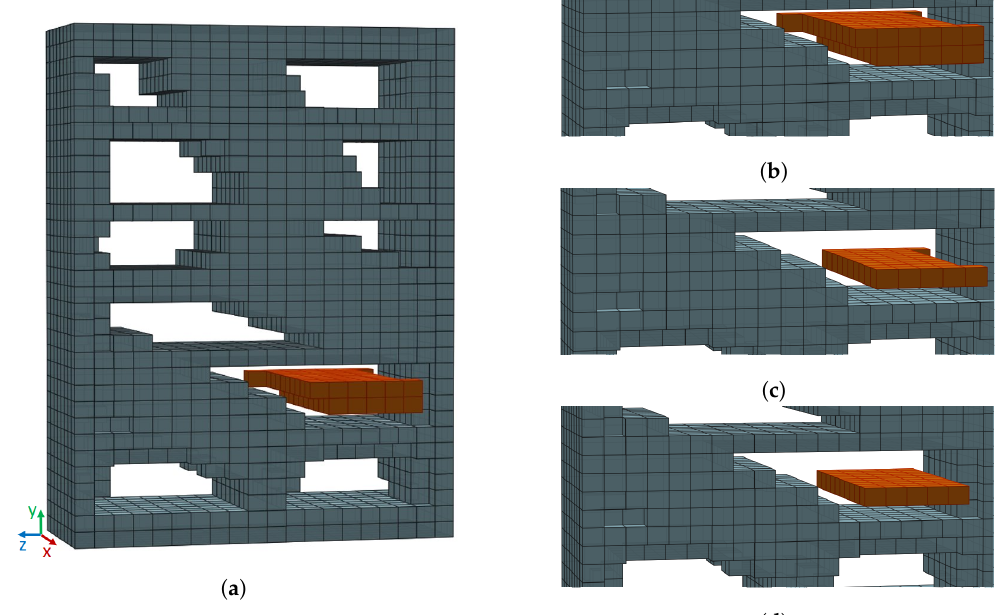
Figure 2. Example of voxelized storage furniture model (bookshelf) with detected free space core (FSC—orange voxels). ( a ) Front view of furniture model with selected FSC ( b ) FSC zoomed, ( c ) One FSC layer in y -axis direction, ( d ) FSC layer